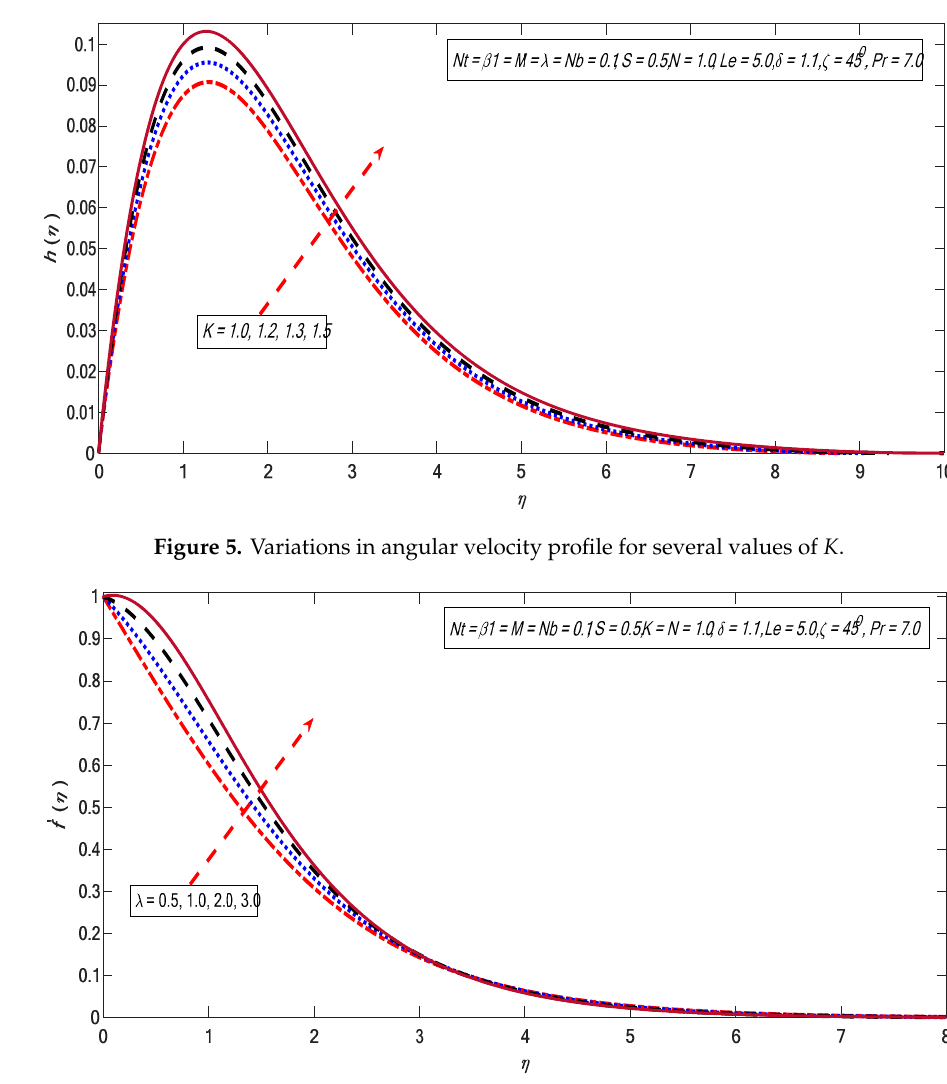
Figure 6. Variations in velocity profile for several values of 𝜆 .